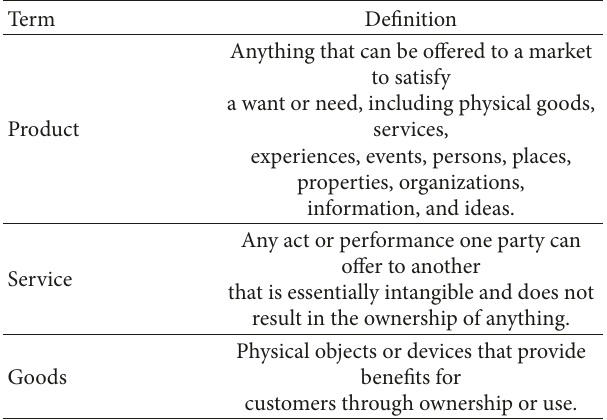
Table 1: Definition of product, service, and goods [18,